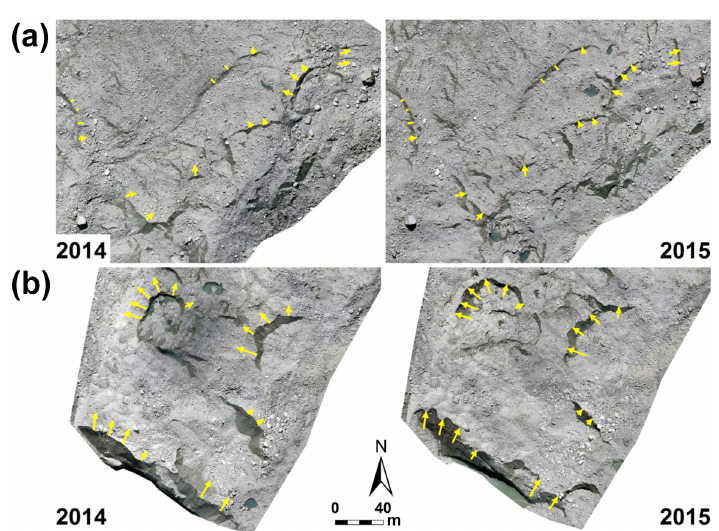
Figure 10. Collapse of the calving face.